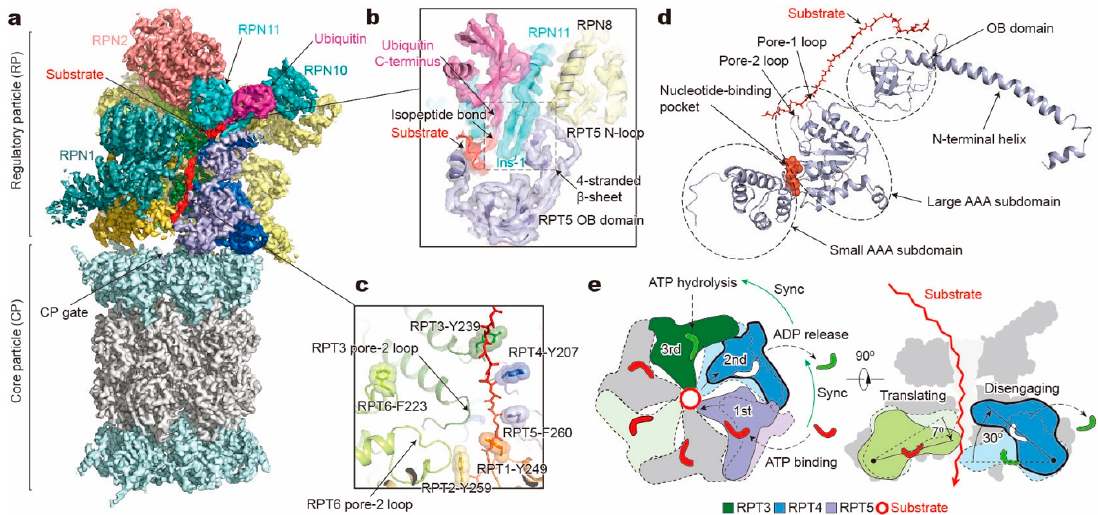
Figure 2. Structure and translocation mechanism of the human 26S proteasome. ( a ) Cryo-EM structure of the substrate-bound human proteasome in state E B at 3.3 Å (EMDB ID: 9218; PDB ID: 6MSE). The RPT1 density is omitted to show the substrate density inside the ATPase ring. The RPN13 density is not observed in this structure. ( b ) A close-up view of the quaternary interface around the isopeptide bond between substrate and ubiquitin. ( c ) Architecture of pore loop staircase interacting with the substrate. Aromatic residues in pore-1 loops are labelled. ( d ) Molecular model of RPT5 in state E B , with ATP bound and substrate engaged. ( e ) Schematic of mechanical substrate translocation of proteasomal ATPases. Synchronization of nucleotide processing in three adjacent ATPases (left) causes differential vertical rigid-body rotations in each substrate-engaged ATPase that cooperatively transfer the substrate (right).